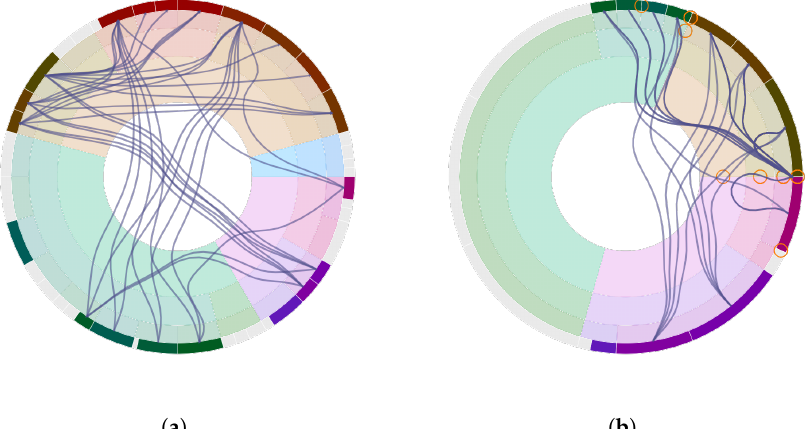
Figure 22. ( a ) Relevance filtering. Only the most relevant concepts are kept, while the least relevant ones are filtered out and depicted in grey color. ( b ) Outdegree resizing. Concepts re-sized according to their outdegree. Assembler Basics was filtered out according to its relevance but it turns out to have a high number of